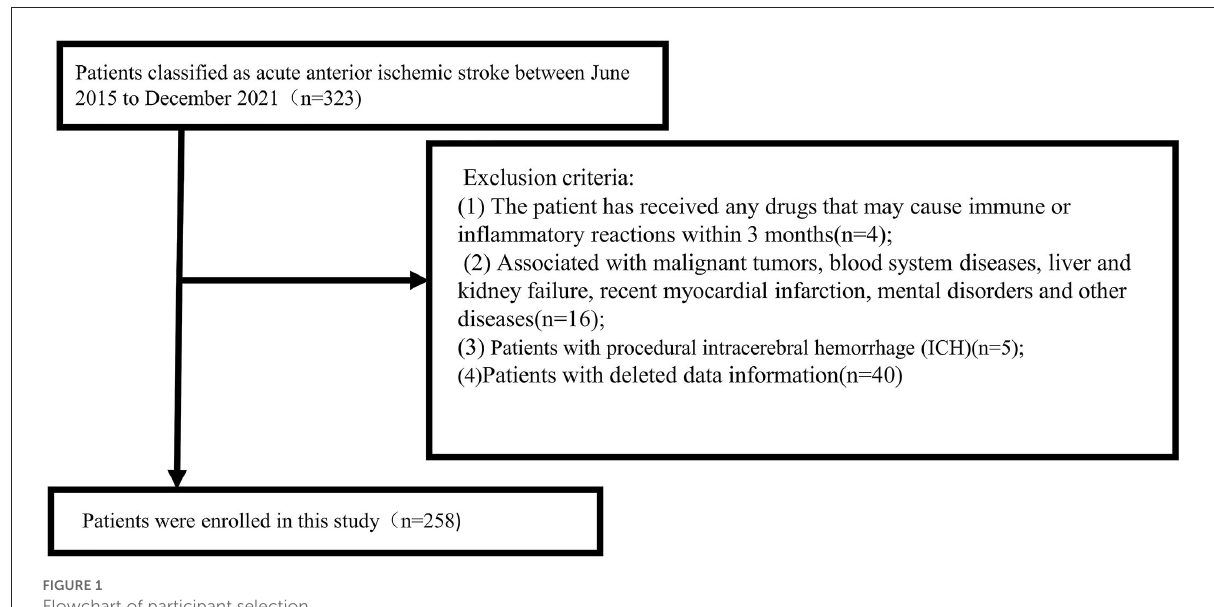
FIGURE1 Flowchart of participant